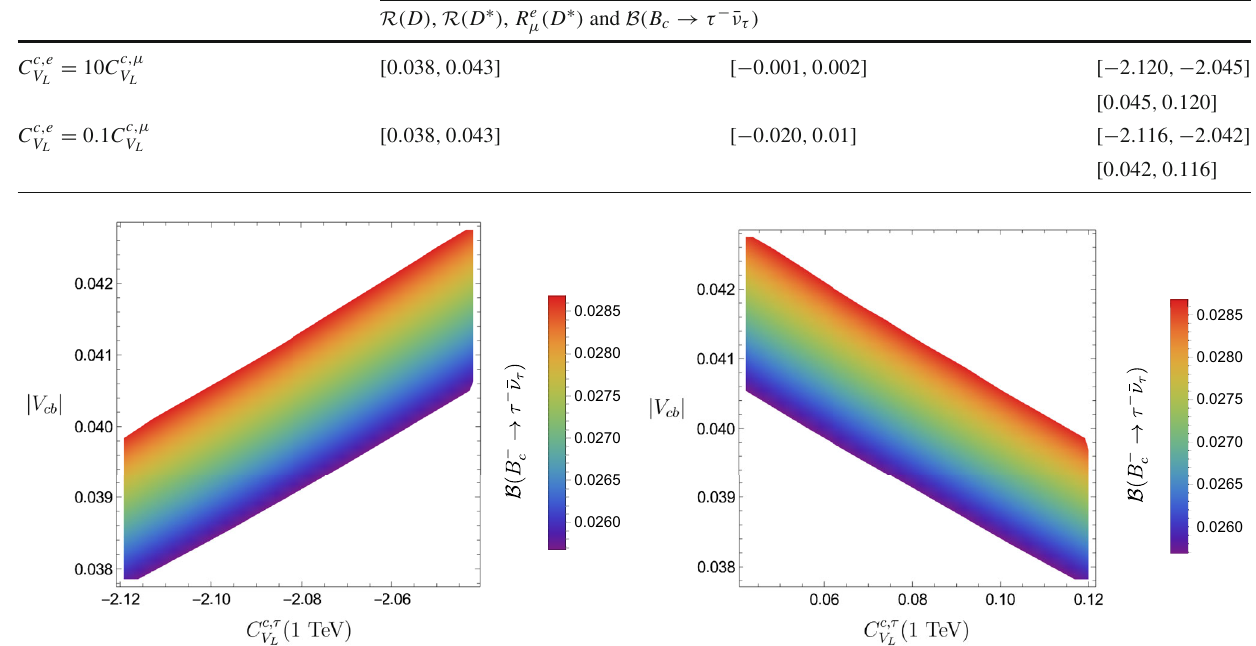
Fig. 21 Values for | V cb | and C c ,τ compatible with the bound for B ( B c → τ − ¯ ν τ ) presented in Eq. V L